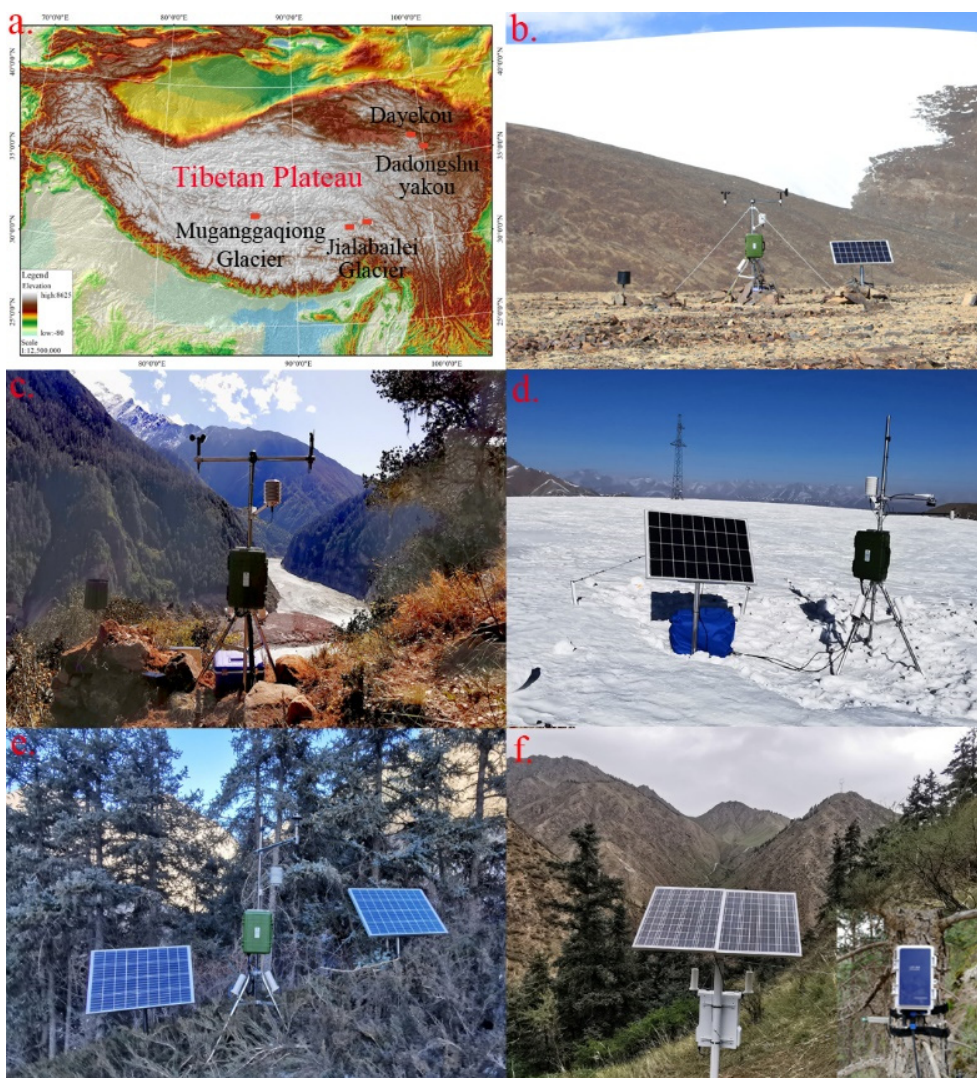
Figure 5. Locations of the five ground IoT terminal devices and observation facilities in the far-most area of the TP ( a ) and photos of these installations at the end of the Mugagangqiong glacier (N 32.220°, E 87.485°, 5706 m.a.s.l.) ( b ), at the dammed point on the Yarlung Zangbo River below the Jialabailei glacier (N 29.748°, E 94.934°, 3033 m.a.s.l.) ( c ), in the Dadongshuyakou snow-covered area (N 38.015°, E 100.244°, 4174 m.a.s.l.) ( d ), and at two sites in the Dayekou forest area (N 38.580°, E 100.292°, 2564 m.a.s.l.) ( e , f ).